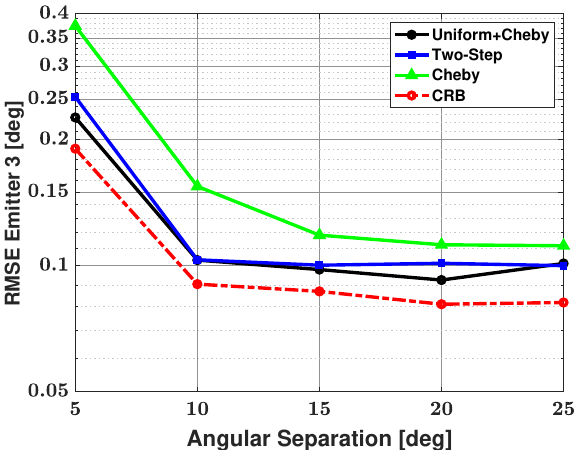
Figure 9. RMSE in the estimated direction of the third, weakest emitter versus angular separation between emitters #2 and #3: the three proposed methods are used for estimation; SNR of emitter #1 = 18 dB, emitter #2 = 25 dB, and emitter #3 = 0 dB, respectively; 100 snapshots; and 500